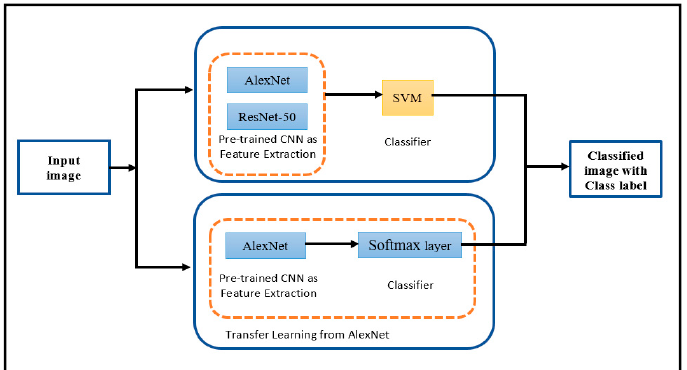
Figure 2. An overview of system approaches.